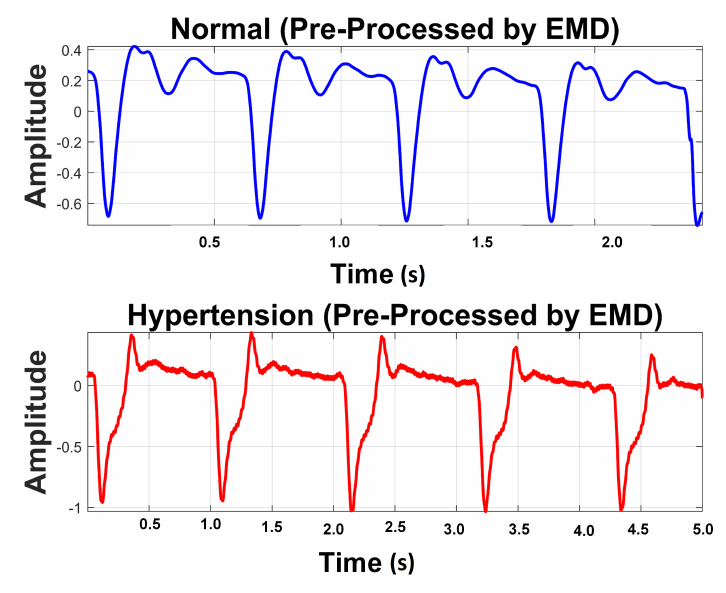
Figure 9. Preprocessed signal using EMD.